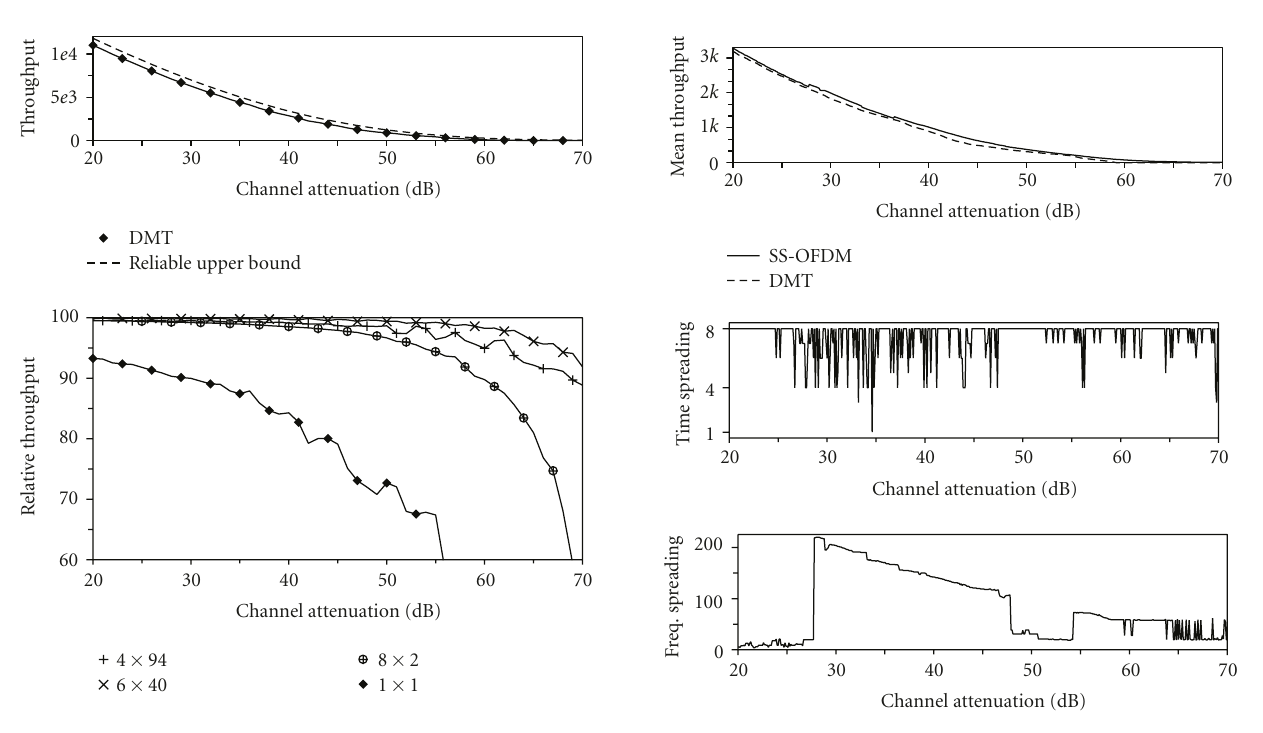
Figure 12: Average throughput per user of DMT and SS-OFDM, and corresponding { L t , L f } SS-OFDM configuration, versus chan- nel